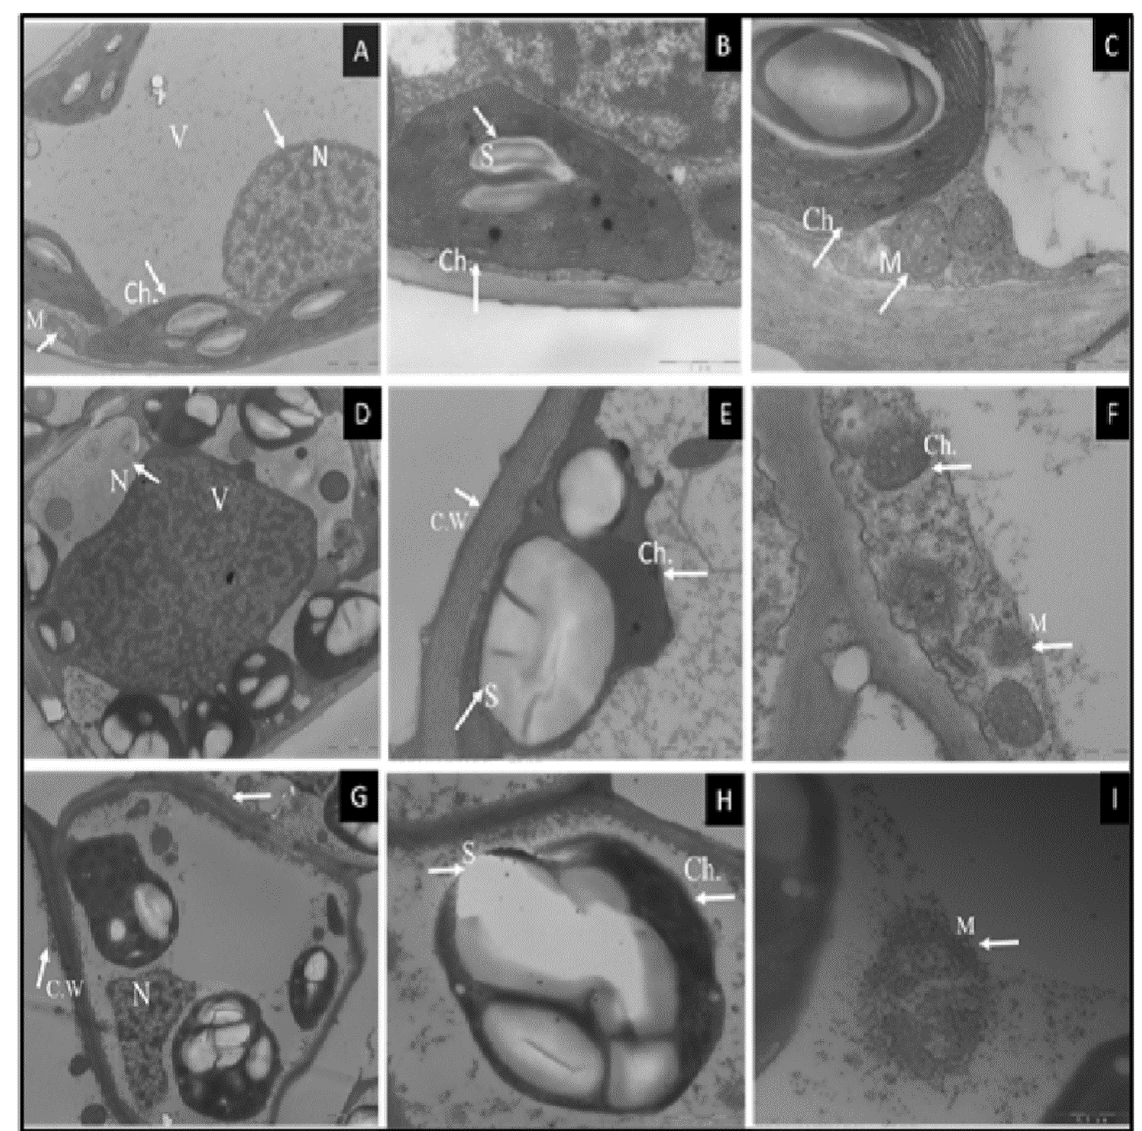
Figure 3. Transmission electron micrographs of a chrysanthemum mesophyll cell and its organelles after exposure to different Cd stress levels. Figure ( A ) represents the control’s N, Ch, M, and V (nucleus, chlorophyll, mitochondria, and vacuole), which are arranged near the plasma membrane. With 10 mgL − 1 of Cd, Figure ( B ) represents the complete structure of Ch (chloroplast), in which more thylakoid (black) and less S (starch) is present. ( C ) represents the Ch (chlorophyll) structure’s enlargement and the higher number of M (mitochondria) which appeared. Under 50 mgL − 1 of Cd, in Figure ( D ), the size of the vacuole also increases and the nucleus is deformed, while the organelles are arranged on all sides. In ( E ), more S (starch) appeared in the Ch (chloroplast) near the CW (cell wall), while in ( F ), Ch (chlorophyll) was more affected compared to M (mitochondria). With 100 mgL − 1 Cd treatment, as shown in Figure ( G ), black-colored material appeared on the cell wall, while the structure of the nucleus and the cell collapse. ( H ) Chl became more spherical and S (starch) increased significantly in size. In ( I ), the disappearance of mitochondria was